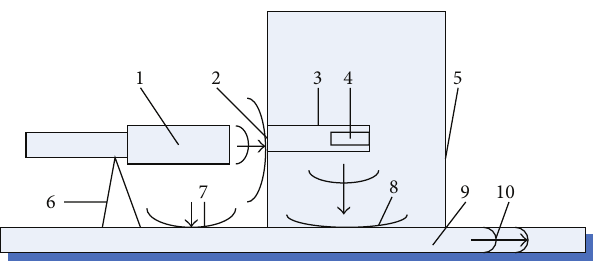
Figure 3: Schematic diagram of the formation of seismic waves. 1: shaped charge; 2: air shock wave and explosive detonation product; 3: penetration hole; 4: rear bullet; 5: boulder; 6: launch support; 7: air shock wave; 8: elastic wave; 9: ground; and 10: seismic